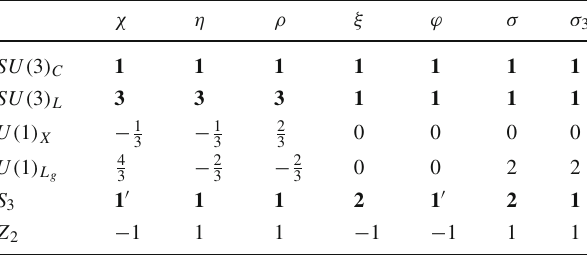
Table 1 Scalar assignments under SU ( 3 ) C × SU ( 3 ) L × U ( 1 ) X